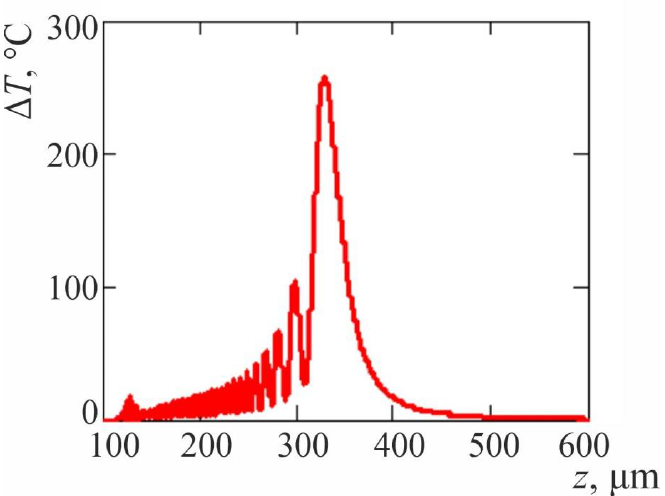
Figure 11. Axial distribution of the temperature increase in the beam, taking into account the temperature relaxation during the pulse. Sphere diameter is 200 µ m. z is axial